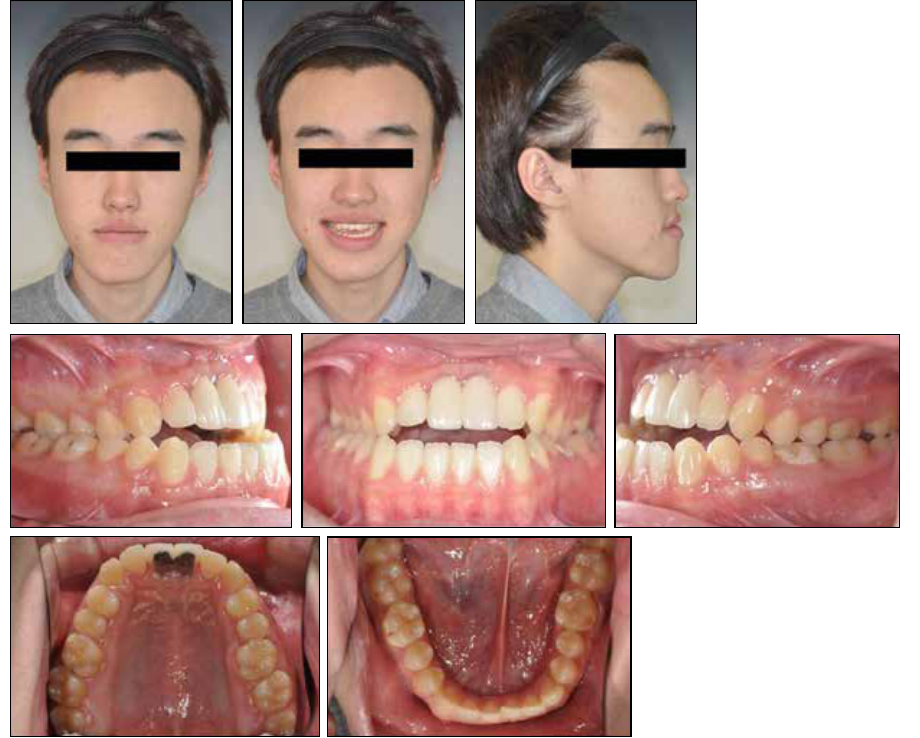
Figure 1. Pretreatment facial and intraoral